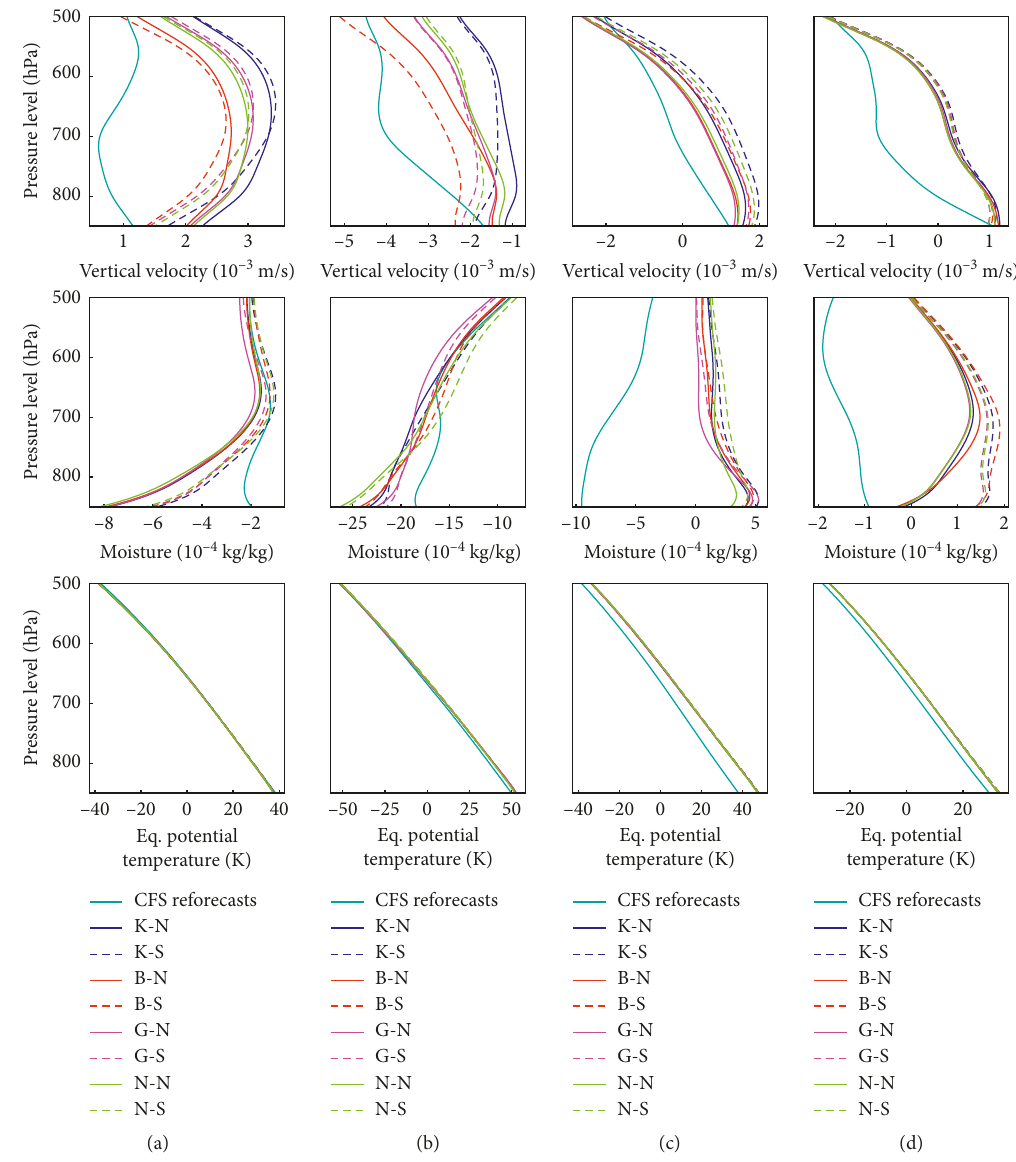
Figure 7: Vertical profiles of biases of areal-averaged vertical velocity, moisture, and equivalent potential temperature over the Han River basin. The bias is generated relative to ERA-5 reanalysis data. (a) Spring. (b) Summer. (c) Autumn. (d)